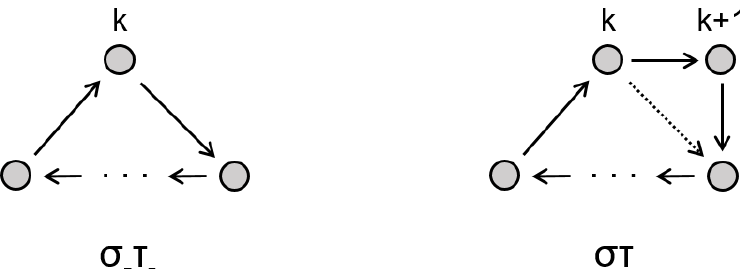
Figure 3 . Comparison between (cid:27) (cid:0) (cid:28) (cid:0) and (cid:27)(cid:28) , when k +1 is a 1-cycle in (cid:27) . Dashed arrows represent the mappings that are in (cid:27) (cid:0) (cid:28) (cid:0) but no longer there in (cid:27)(cid:28) , and identical cycles are not shown. We see that in (cid:27)(cid:28) the element k +1 is inserted in the cycle, but the total number of cycles does not change. where the addition in the indices is modulo d